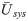
Scatter plots of hydrodynamic parameter distribution computed along the spine.(A) Reynolds number, Re, (B) flow rate amplitude, Qa, (C) stroke volume, SV, (D) hydraulic diameter, Dh, (E) Womersley number, α, and, (F) mean peak systolic, U¯sys, and diastolic, U¯dia, CSF velocity. Dot color represents distance from the FM (blue is near the FM and red is near the SAS termination).